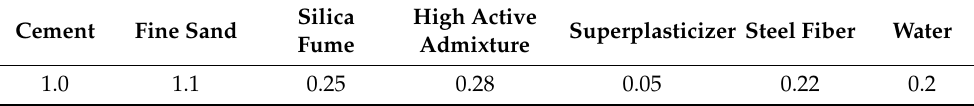
Table 1. Relative weight ratios to cement in the mix